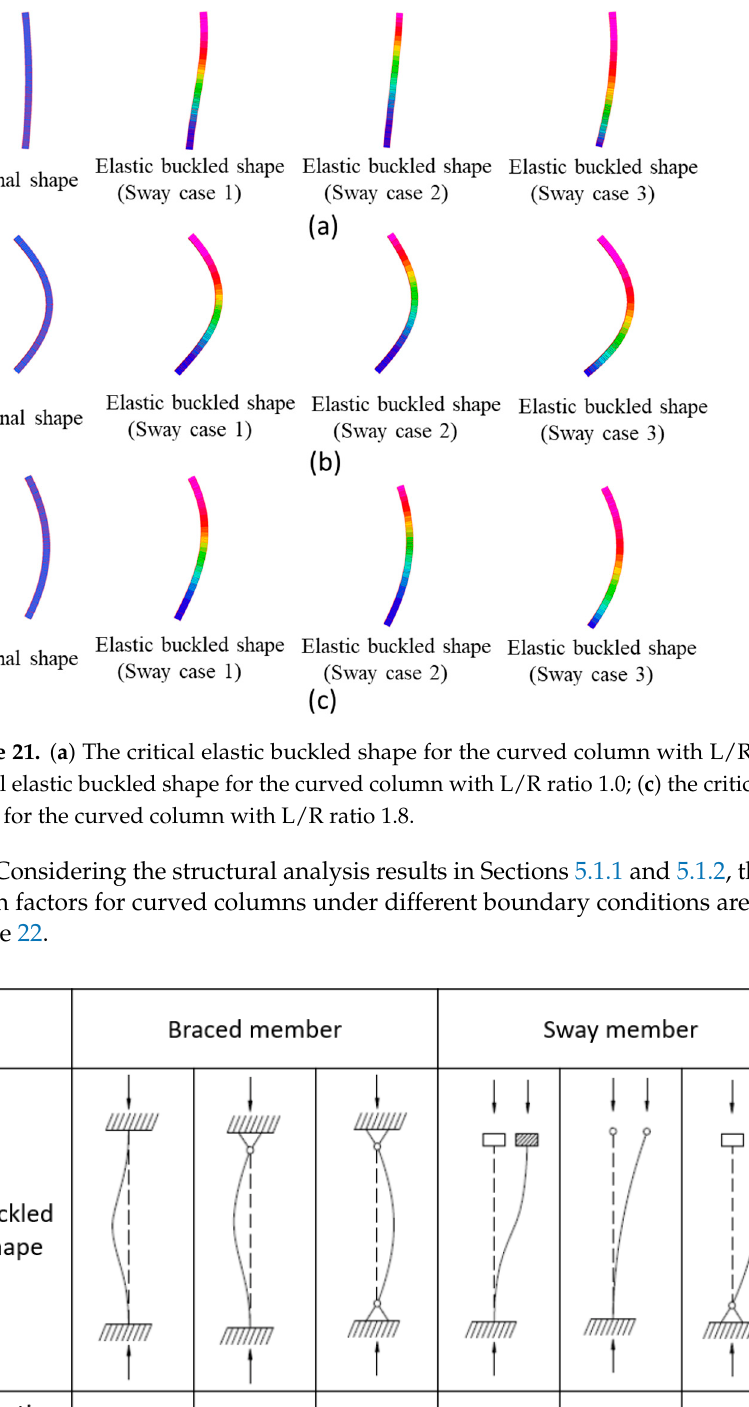
Figure 20. The effective length factor ( k e ) of curved beams under different L/R ratios: ( a ) sway member case 1; ( b ) sway member case 2; ( c ) sway member case 3.